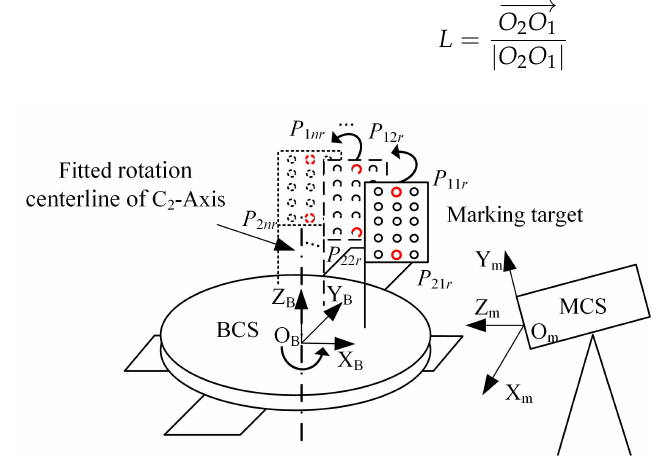
Figure 8. The measurement process of C 2 -axis rotation